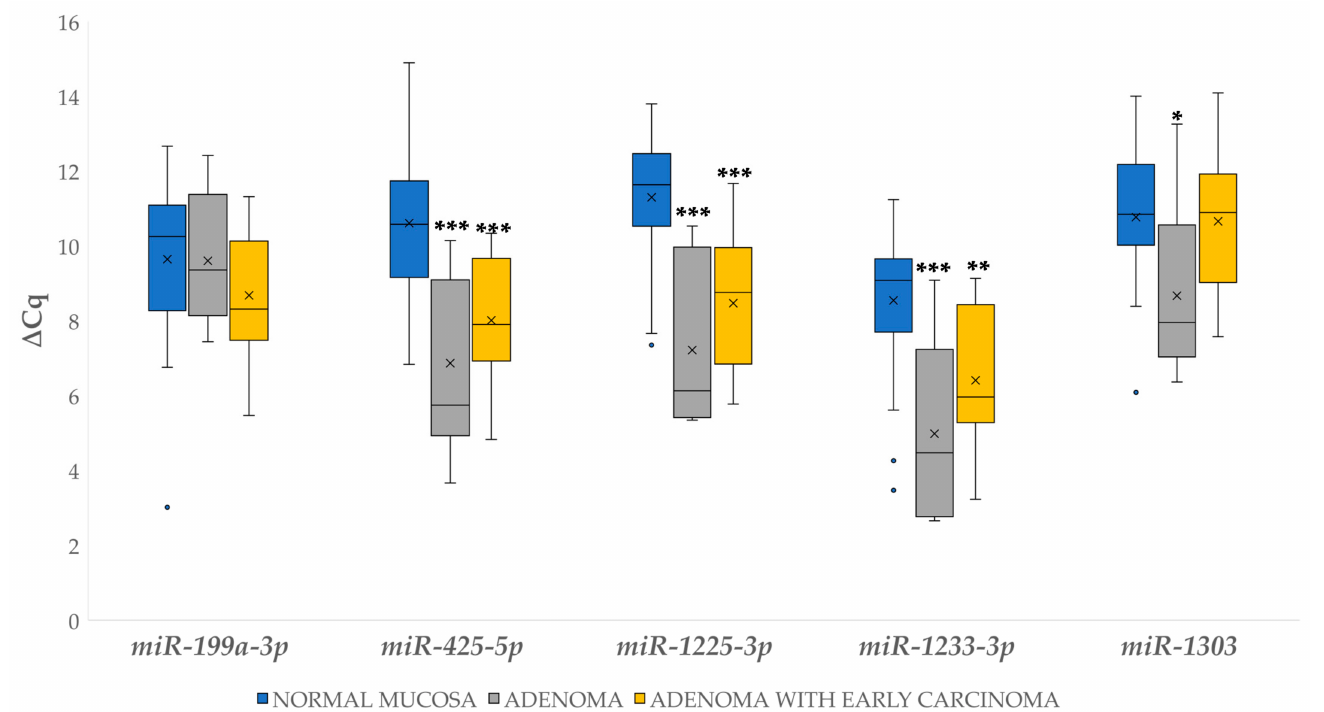
Figure 5. Expression ( ∆ Cq) of the investigated miRNAs in normal mucosa, adenoma and adenoma with early carcinoma. Legend: x, mean; ◦ , outlier; * p ≤ 0.05; ** p ≤ 0.01; *** p ≤